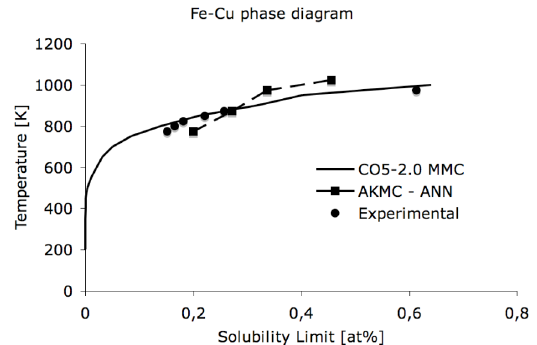
Fig. 18. AKMC results obtained with the use of the FeCu3nn trained MLP. The CO5 curve shows the Cu solubility limit of the inter-atomic potential used for the energy